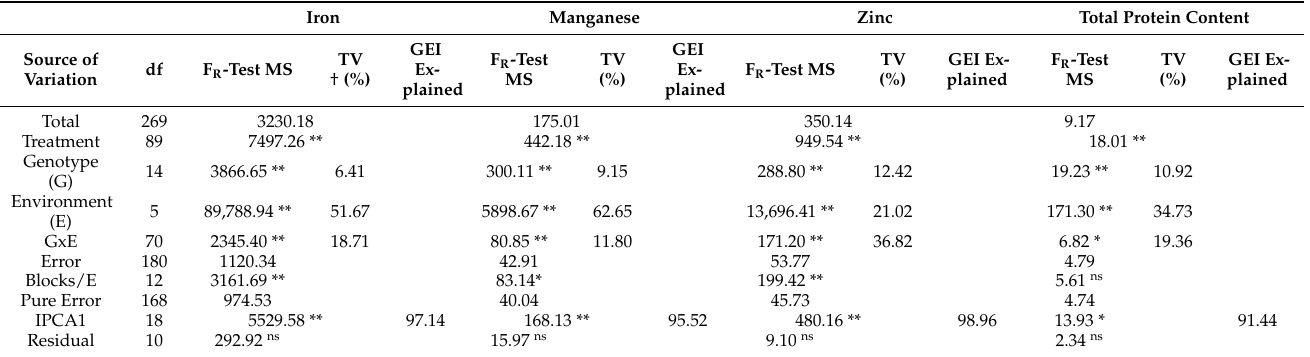
Table 3. Additive main effects and multiplicative interaction analysis of variance for nutrient content of 15 cowpea genotypes evaluated in six environments of South